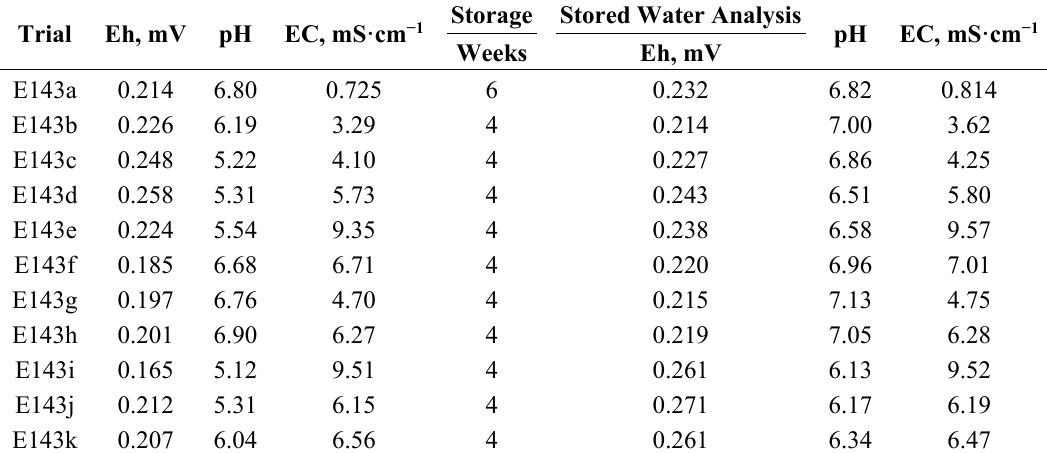
Table C6. ZVM TPA Example (Trial E143): Product Water Composition.